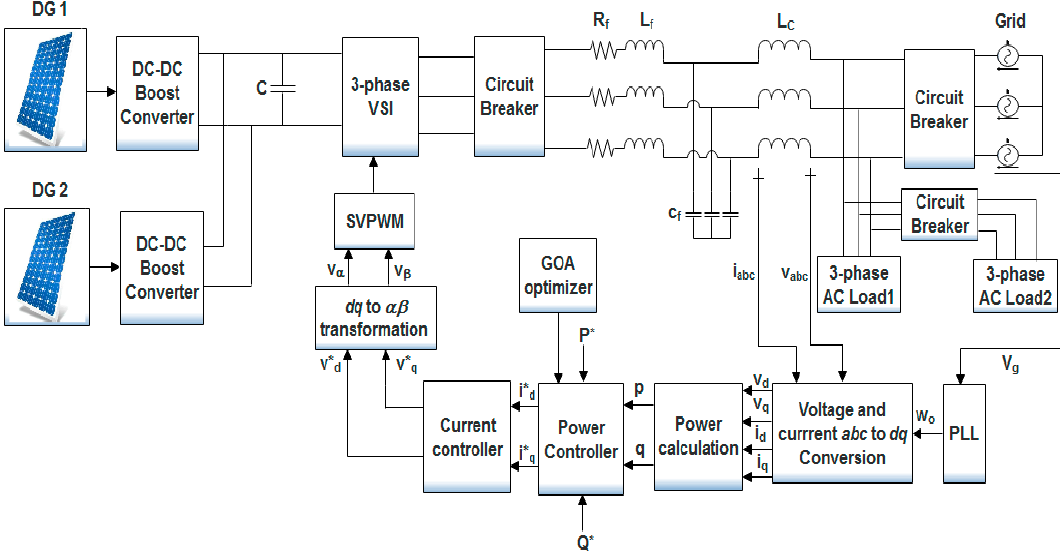
Figure 2. Grid-connected MG model with the proposed control strategy.